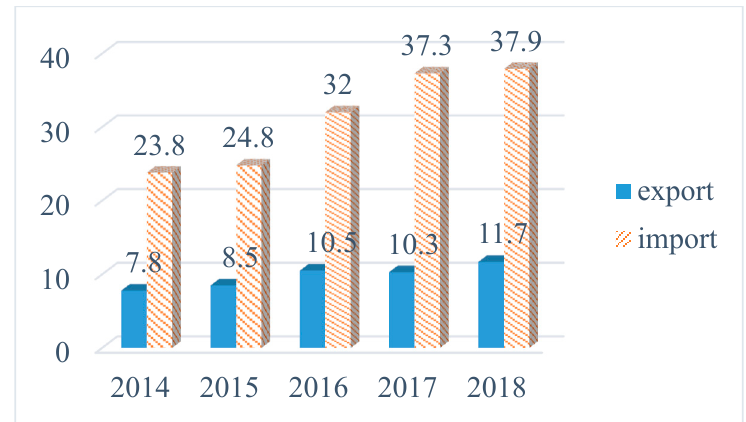
Figure 8. Beef trade (in thousands of tons) [27].